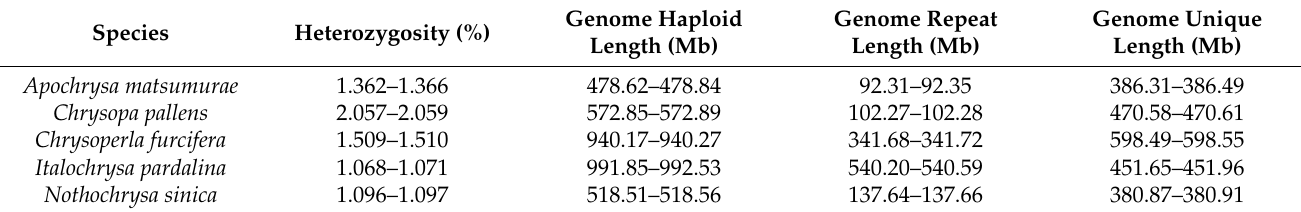
Table 2. Genomescope results of species used in this